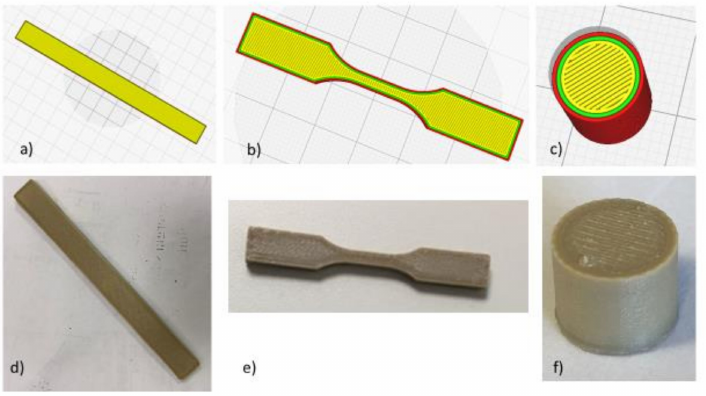
Figure 3. ( a , d ) CAD (upper) and photo (lower) of 3D-printed flexural test specimen; ( b , e ) tensile test specimen; ( c , f ) outgassing